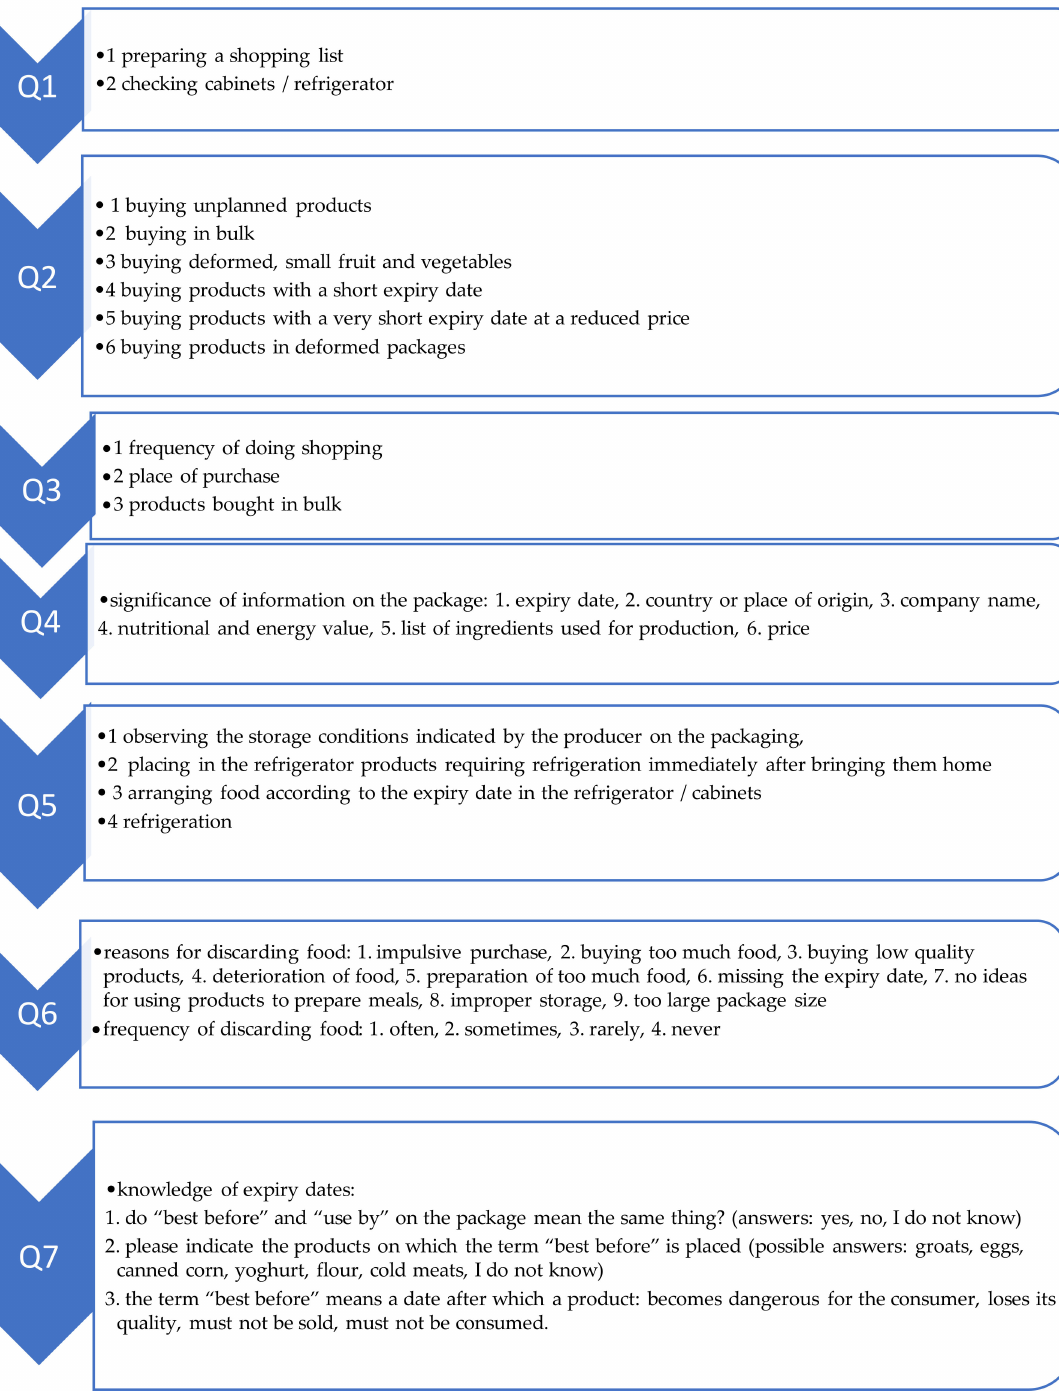
Figure 1. Schematic diagram of the issues used for segmentation of